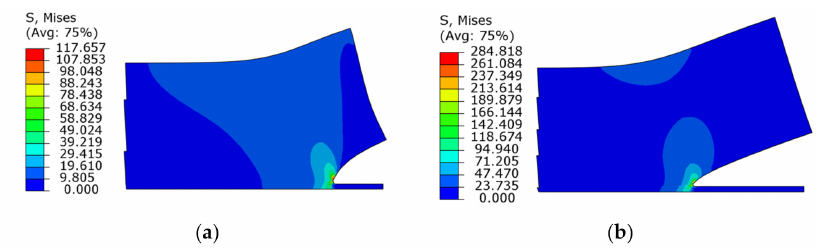
Figure 7. The Von Mises equivalent stress distribution in the crack tip with the crack length of: ( a ) 10 µ m; ( b ) 20 µ m.